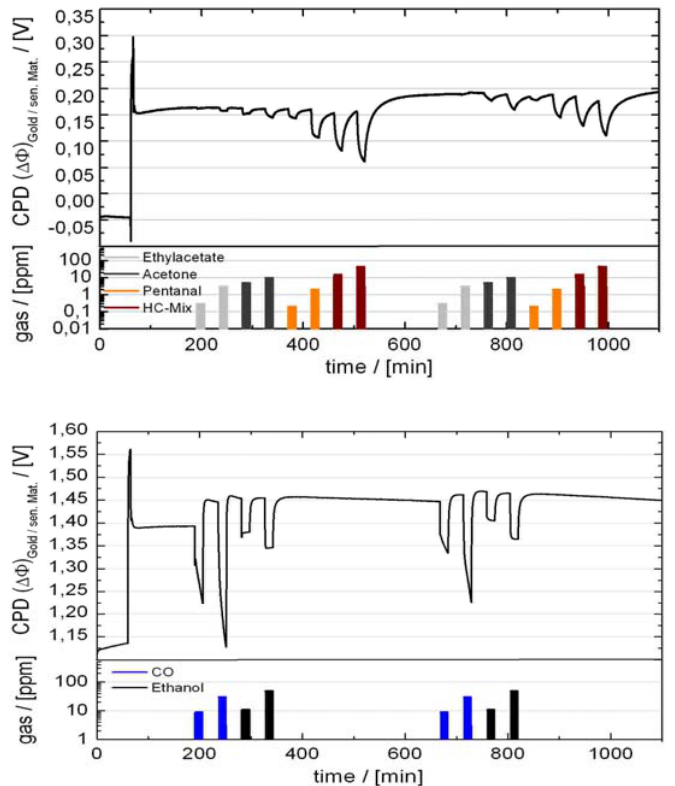
Figure 21. Detection of the lead gases for “smell” with a Ga 2 O 3 /Pt sensing layer with a room temperature-operated GasFET. To keep the sensitivity to the full gas spectrum, an intermittent thermal reactivation (e.g. once in the night for a few min) is